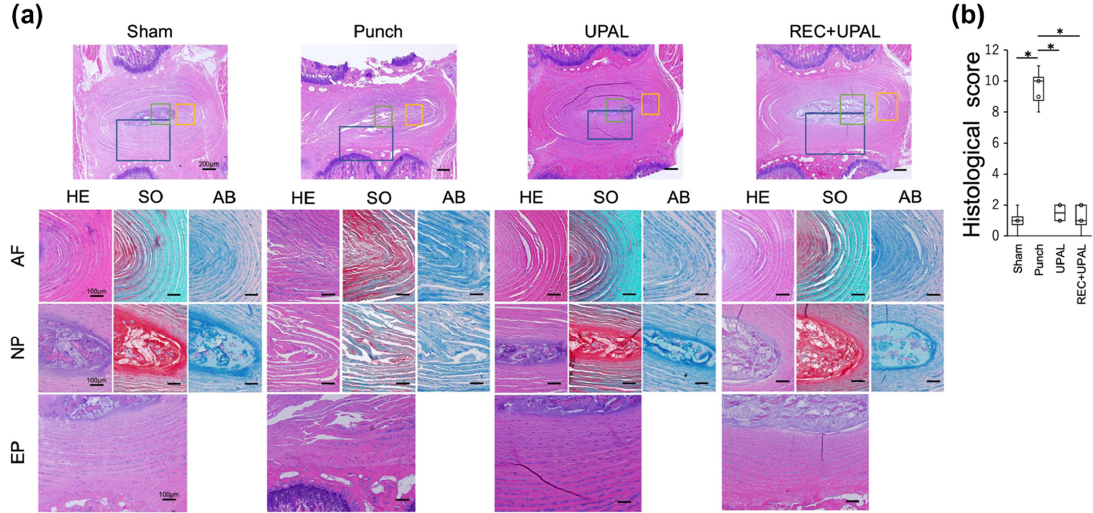
Figure 5. A mixed solution of REC and UPAL prevents intervertebral disc (IVD) degeneration. Histological analysis was performed to evaluate IVD degeneration on postoperative day 28 ( a , b ). Mid-sagittal sections (5 µ m thick) of rat IVDs were obtained and stained with hematoxylin and eosin (H&E), safranin O (SO), and alcian blue (AB) to evaluate a histological score. ( a ) Representative image of H&E, SO, and AB staining in annulus fibrosus (AF), nucleus pulposus (NP), and endplate (EP) tissues. Scale bar, 200 µ m for the top row and 100 µ m for all other images. ( b ) Histological degeneration score. An asterisk (*) indicates a p -value less than 0.01. The boxes represent the median and the interquartile range, while the vertical lines show the range at each time point (n = 3 rats; n = 6 IVDs in each group).